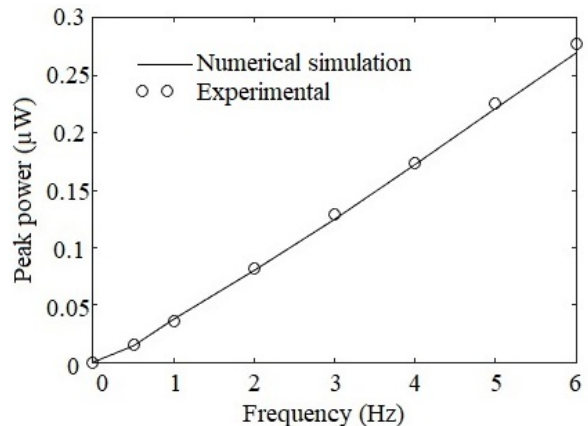
Figure 15. Variation of peak power with frequency.